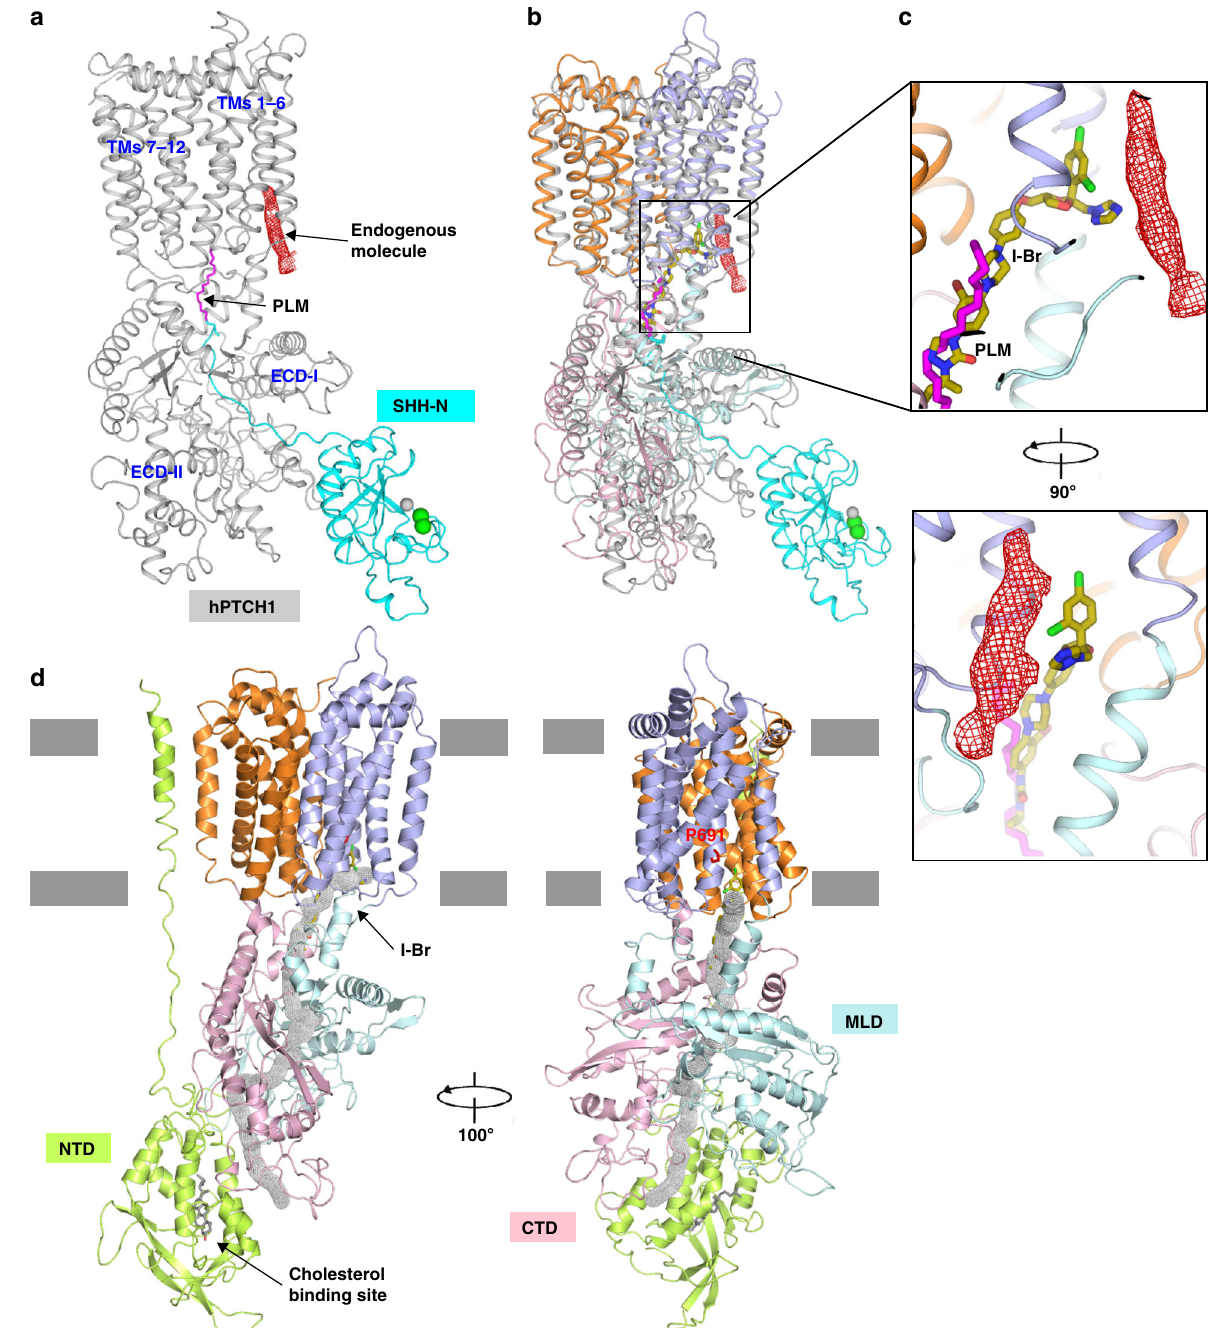
Fig. 5 The itraconazole-binding site on NPC1 resembles the palmitate binding site in PTCH1. a The overall structure of the palmitoylated, Hedgehog- bound PTCH1 structure (PDB: 6E1H). Palmitate (PLM) is shown as magenta sticks and the endogenous molecule density in the SSD is shown as red mesh, calcium and zinc as green and gray spheres, respectively. b Structural comparison of NPC1 and PTCH1. c The itraconazole and palmitate bind to a similar cavity of NPC1 and PTCH1. d Structure of the I-Br bound NPC1 with the putative tunnel in gray; the I-Br and residue Pro691 are